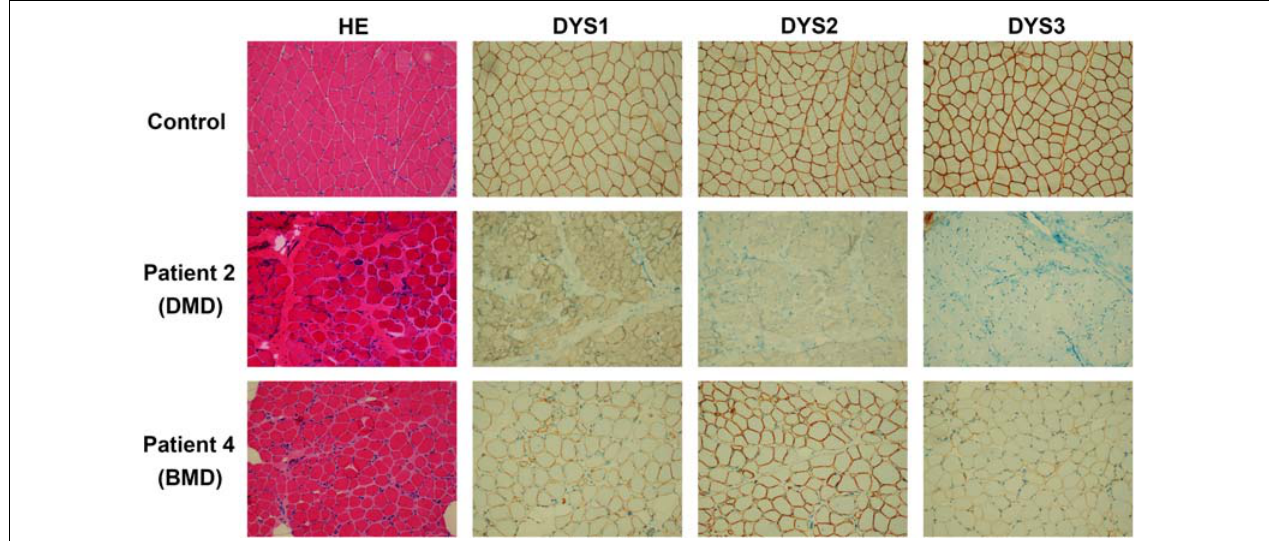
FIGURE 1 | Results of histopathological and immunochemical analysis. The DMD patient (patient 2), BMD patient (patient 4), and a healthy control are shown. Patient 2 presents the absence of dystrophin expression. While patient 4 shows dystrophin reduction.